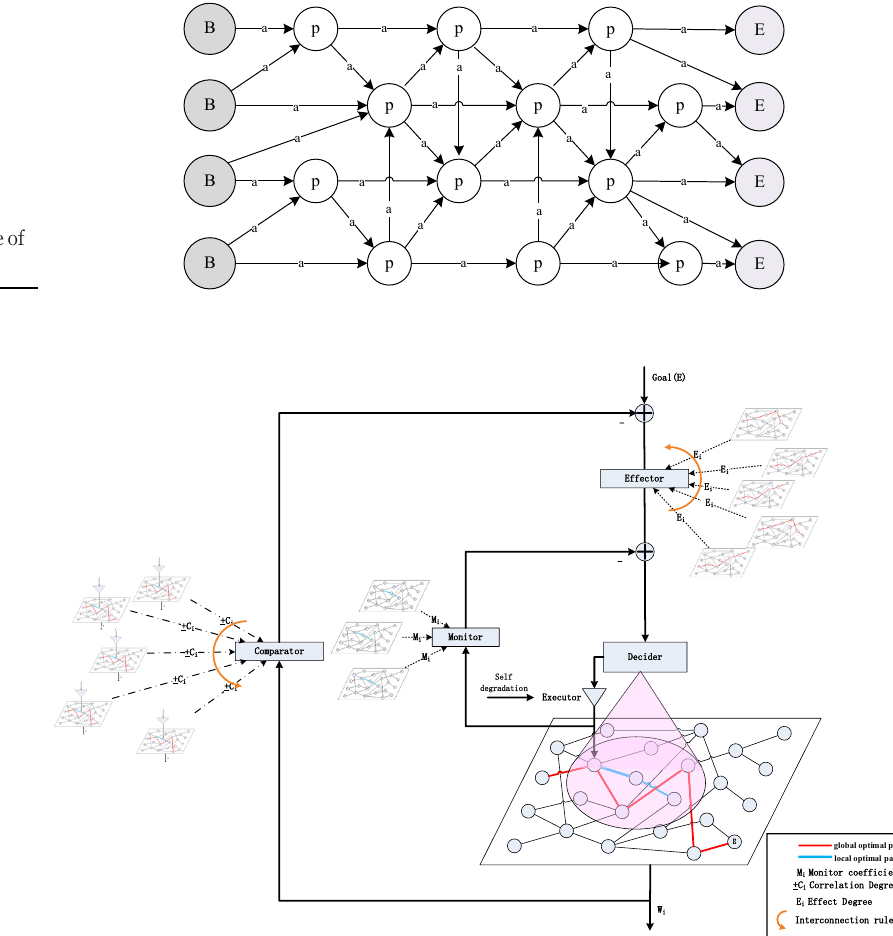
Figure 2. Primitive